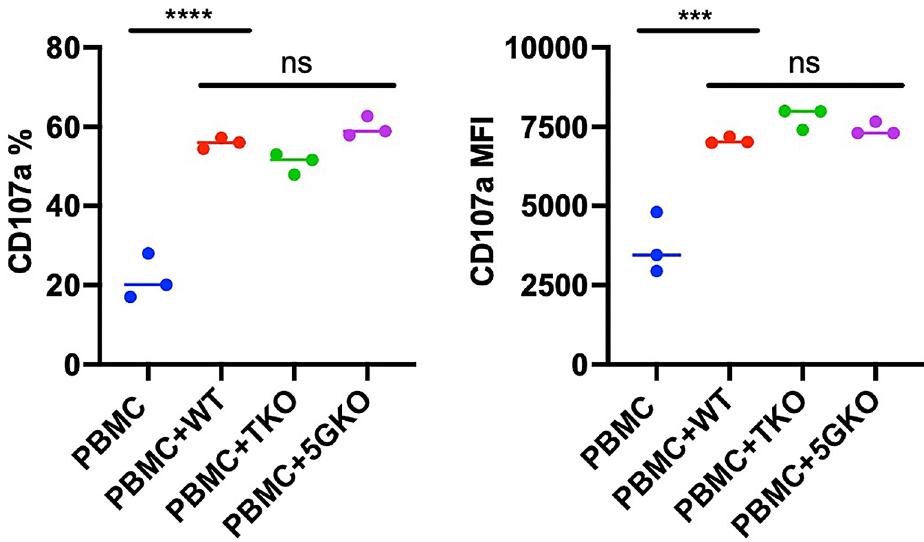
Figure 6. Human NK cell degranulation following porcine cell stimulation. Human PBMCs from three donors were treated with human IL-2 (20 ng/mL) for 5 days to expand NK cells, then cocultured with WT, TKO, and 5GKO ipLDEC for 2 h. Cells were stained with antibodies to CD45, CD3, CD56, and CD107a. Flow cytometry analysis was gated on NK cells (CD3 - CD56 + ) and monitored for the percentage of CD107a positive cells ( left ) and surface expression of CD107a (MFI) ( right ). Statistical significance was calculated by one-way ANOVA, Tukey’s multiple comparisons test ( ns not significant; ***p < 0.001; ****p <